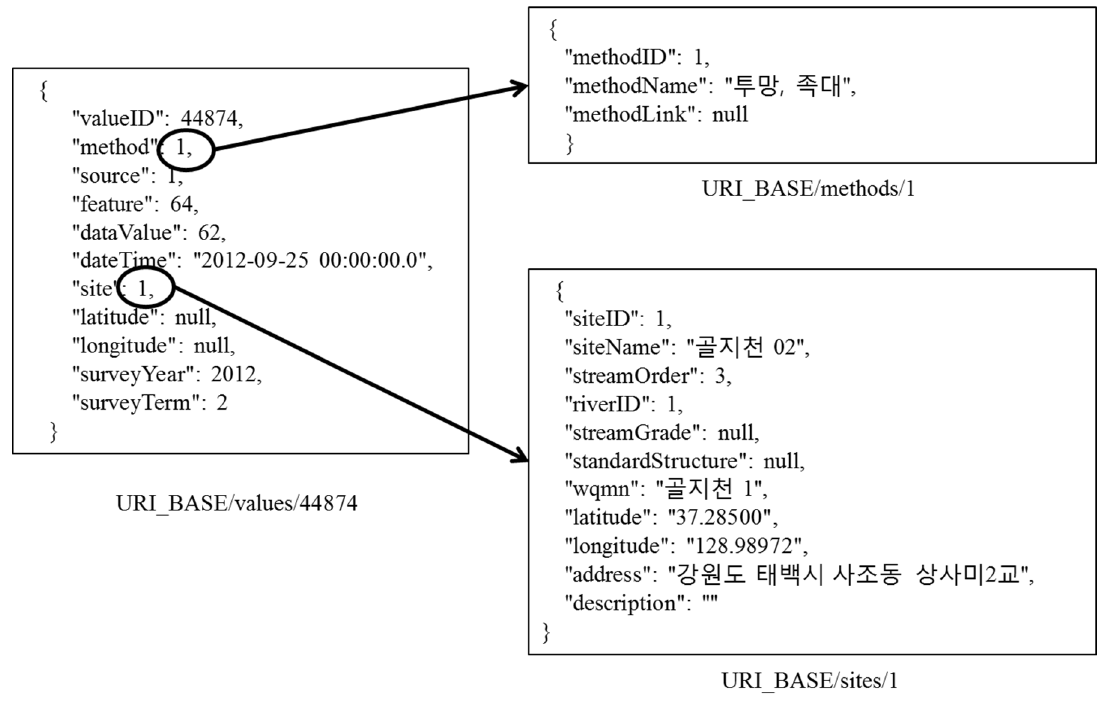
Figure 9. Relationships between the Observation and other collection resources.